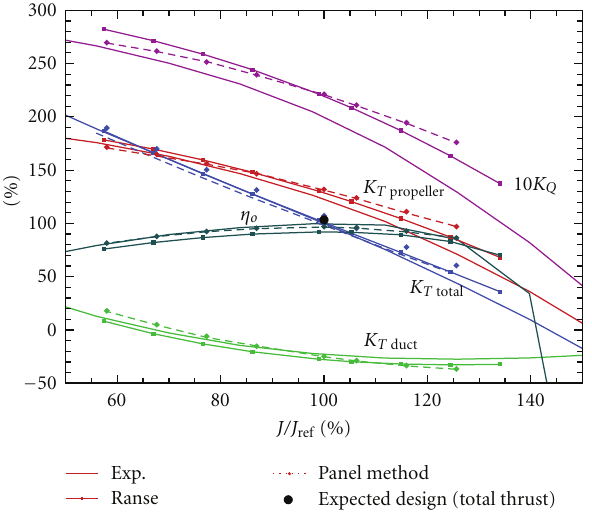
Figure 13: Non-dimensional open water propeller